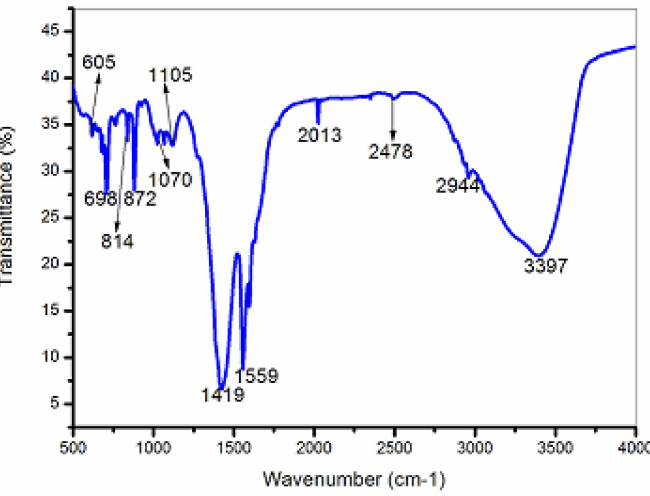
Figure 5. FT-IR spectrum of biosynthesized AgNPs using bark extract of A. indica . Phytochemical screening of A. indica ’s bark showed the existence of flavonoids, tannins, carbohydrates saponins, and phenols in both aqueous and methanolic bark extract, whereas no traces of alkaloids, cardiac glycosides, and amino acids were detected in both